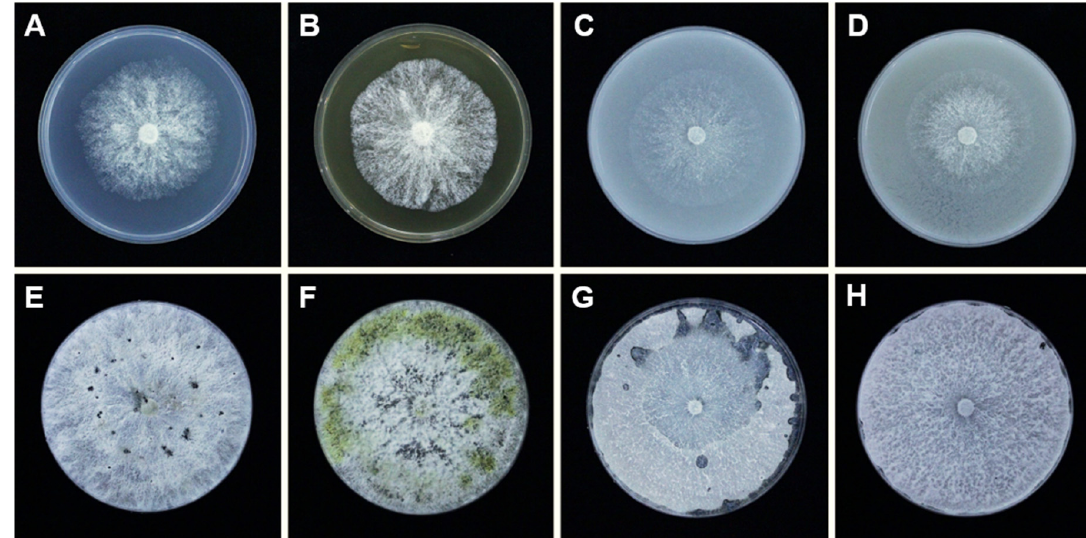
Figure 1. The cultural characteristics of Diaporthe passifloricola (NFIF-3-21) on different media. The isolate was incubated at 25 °C in the dark. ( A ) and ( E ), PDA medium, ( B ) and ( F ), MEA medium, ( C ) and ( G ), CMA medium, ( D ) and ( H ), OMA medium. Note: A – D , Colonies after 3 days incubation, E – H , Colonies after 30 days incubation.